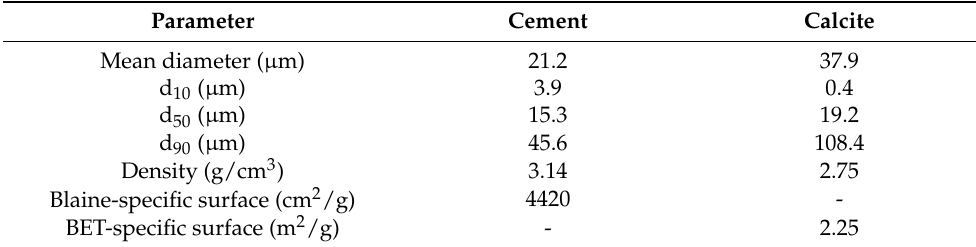
Figure 1. Particle size distributions of cement and calcite. Table 1. Physical properties of cement and calcite.